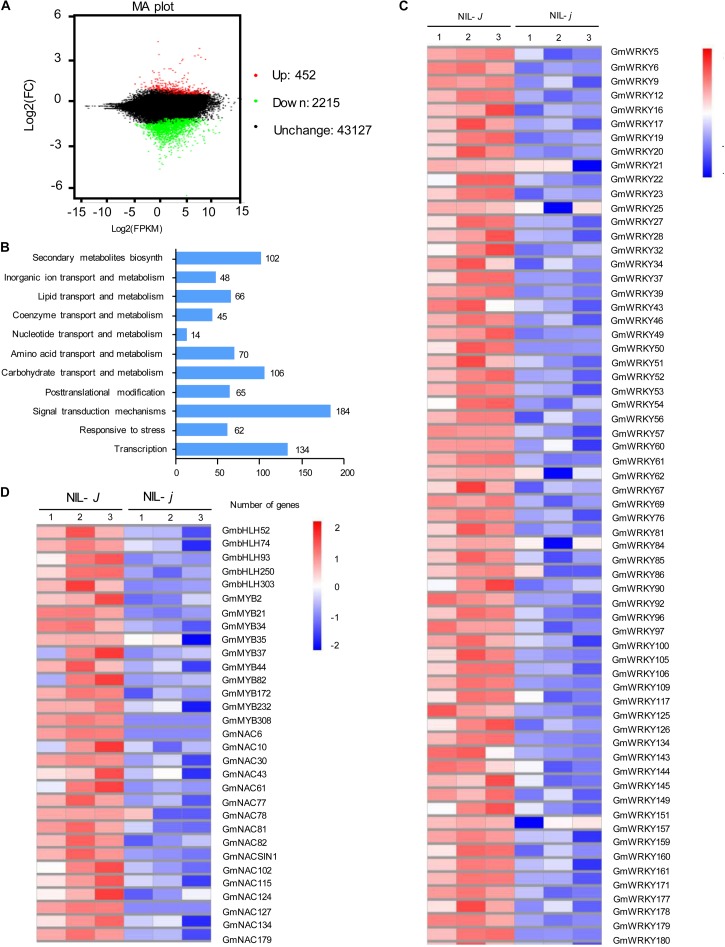
Transcriptomic analysis of NIL-J and NIL-j soybean plant. (A) Numbers of genes showing differential expression between NIL-J and NIL-j soybean plant in non-NaCl-stressed seedings. (B) GO terms that were statistically enriched in differentially expressed genes in NIL-J and NIL-j RNA-seq assay. The numbers near the columns indicate the number of differentially expressed genes. (C,D) The heat map of differential expression of WRKY, bHLH, MYB, and NAC family genes in NIL-J and NIL-j. The numerical values for the blue-to-red gradient bar represent log2-fold change relative to the control sample.